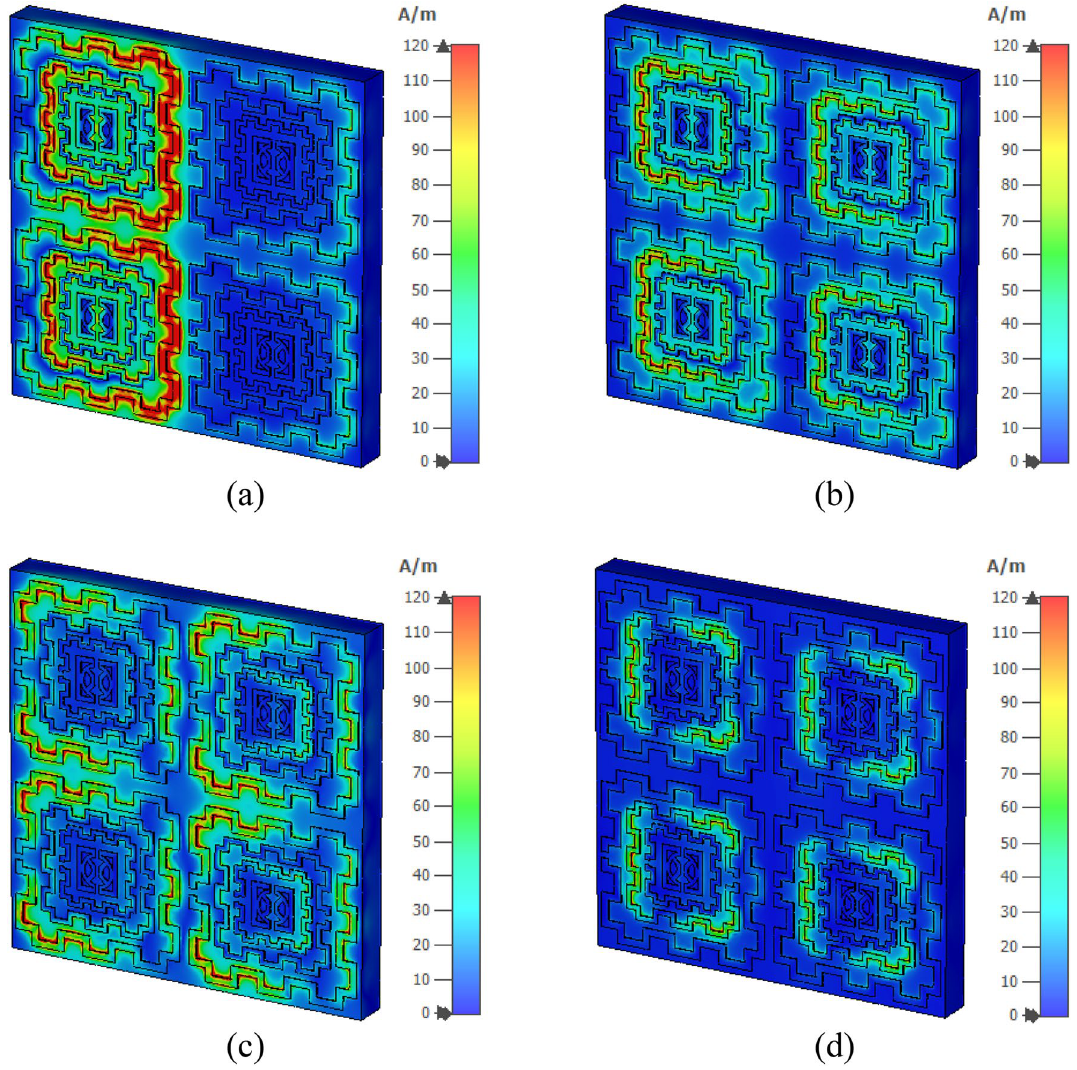
Figure 24. Magnetic field distribution of 2 × 2 array at 2.63 GHz, ( b ) 4.28 GHz ( c ) 8.9 GHz, and 13.7 GHz. (CST STUDIO SUITE 2019, https:// www. 3ds. com/ produ cts- servi ces/ simul ia/ produ cts/ cst- studio- suite) 28